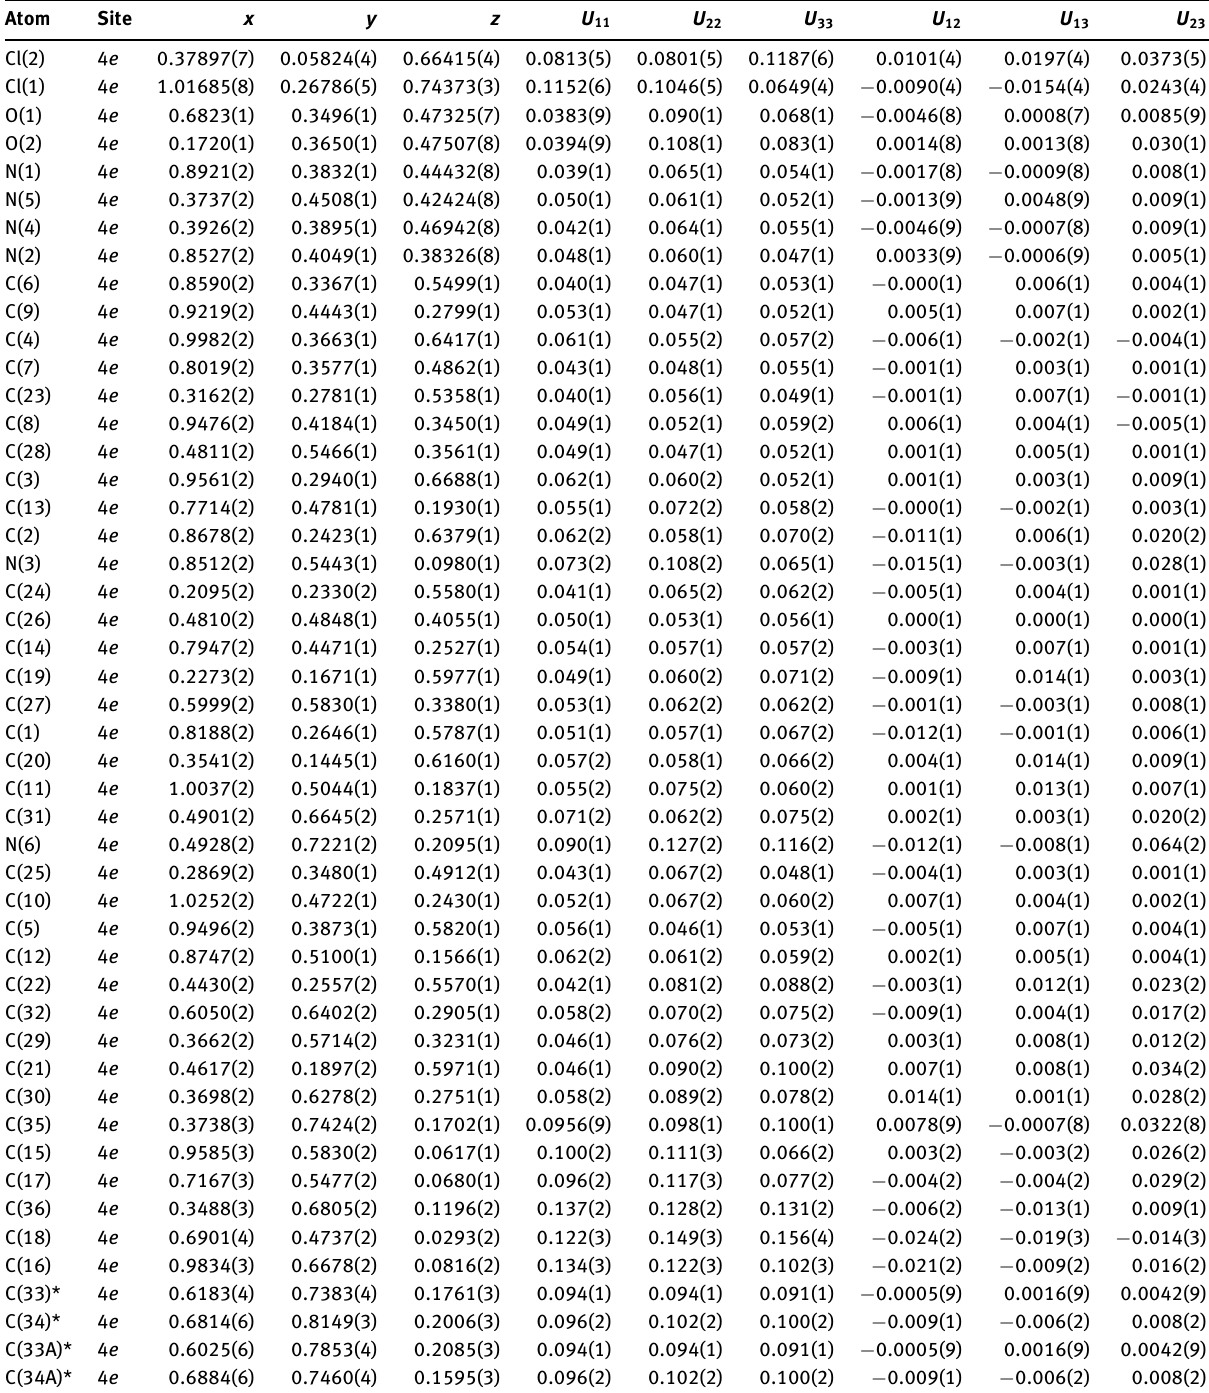
Table 3: Atomic displacement parameters (Å 2